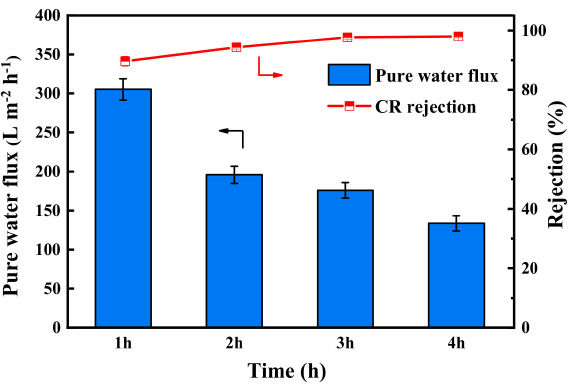
Figure 6. The pure water flux and CR rejection of PES/Fe-TA membrane at different TA assembly